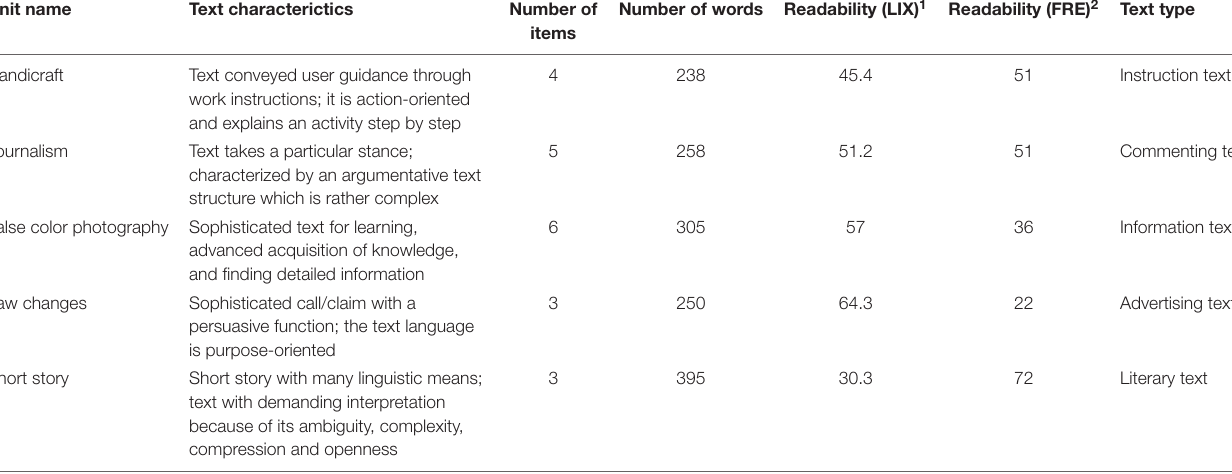
TABLE 2 | Text characteristics of the STC test.